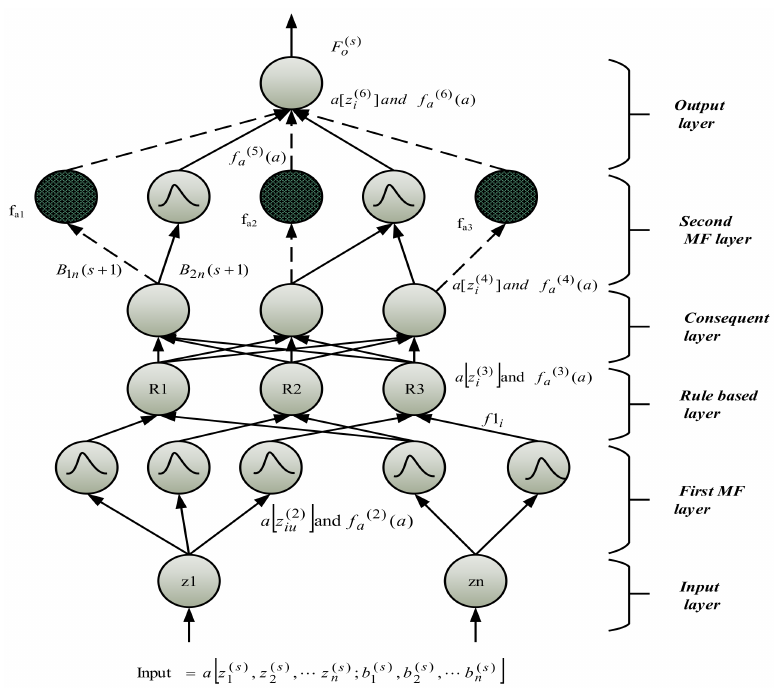
Figure 2. The proposed model of the SsIF-NN